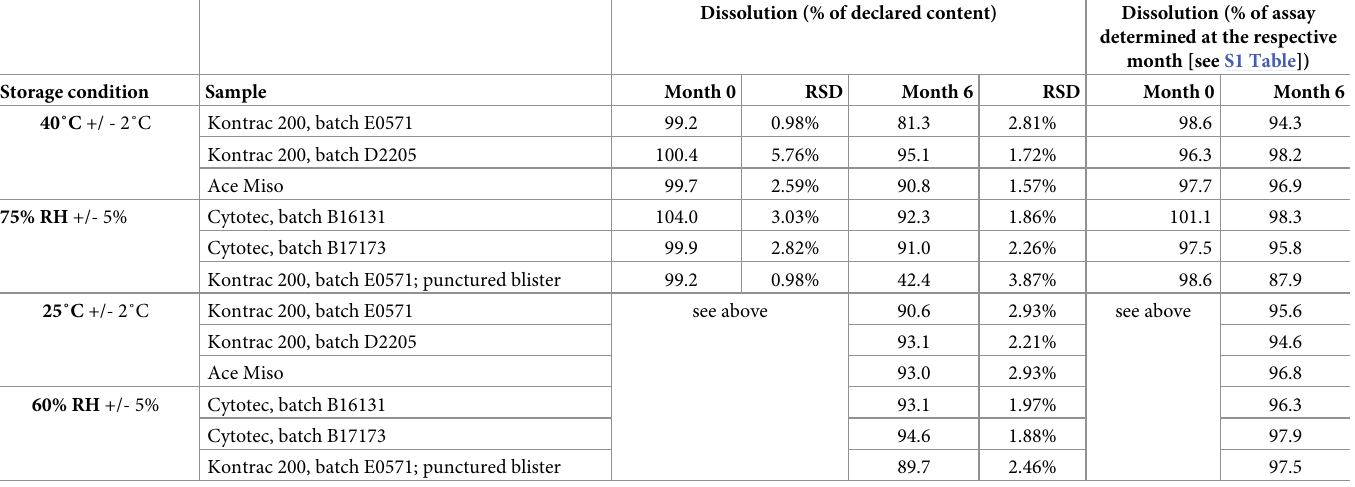
Table 2. Dissolution testing results of misoprostol tablets stored at two different conditions, 0 and 6 months.